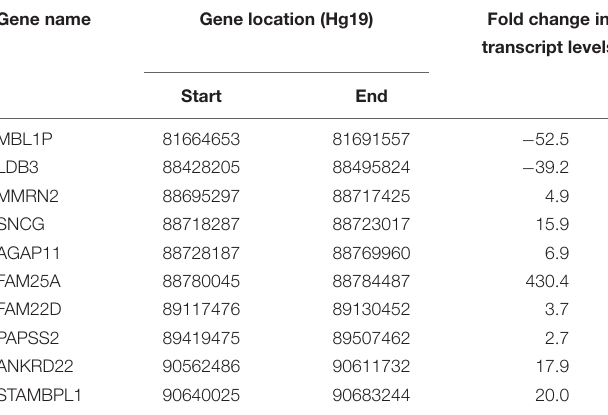
TABLE 2 | List of known genes on 2p22 locus with more than twofold change in transcript levels between BEC20W and BEC40W cells, as represented in Figure 4 .